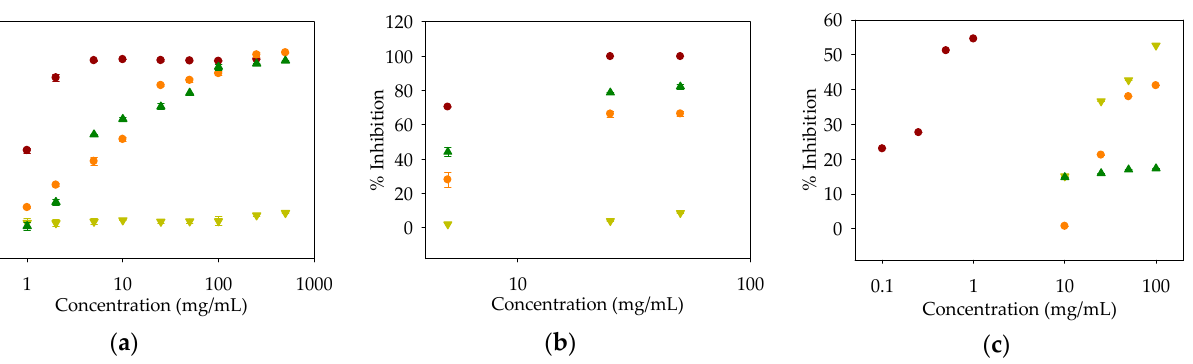
Antioxidants 2021 , 10 , x FOR PEER REVIEW